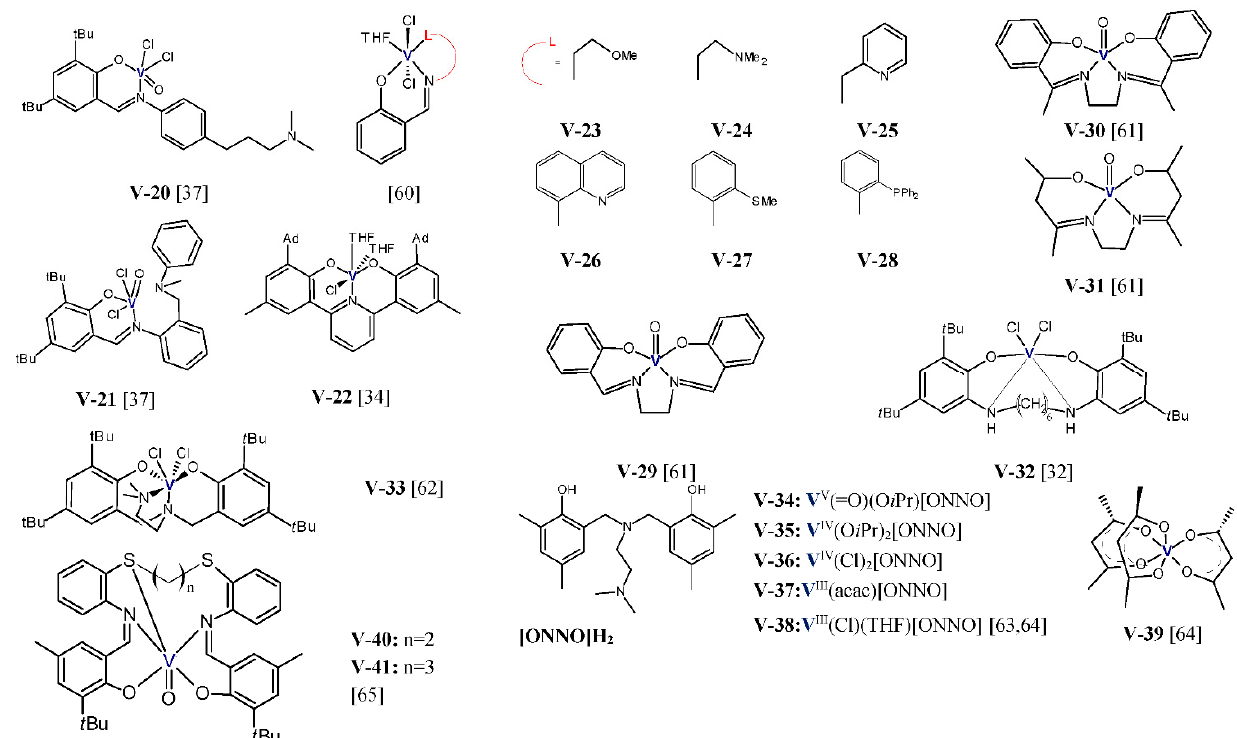
Figure 5. Vanadium complexes investigated as precatalysts for ethylene/1-olefin copolymerization [32,34,37,60–65].